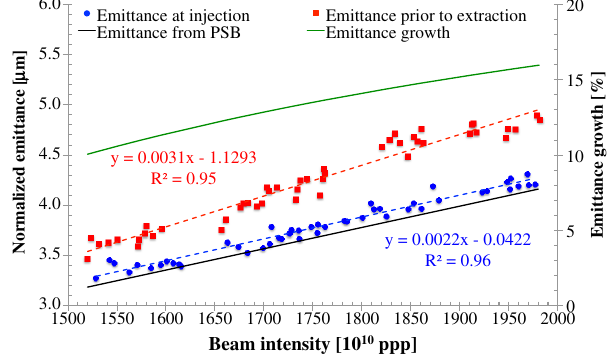
FIG. 4. Normalized 1 σ vertical emittance in the PS ring at injection and after beam splitting as a function of total beam intensity. The relative emittance growth is also shown together with the measured emittance evolution vs intensity out of the PSB (see Fig.